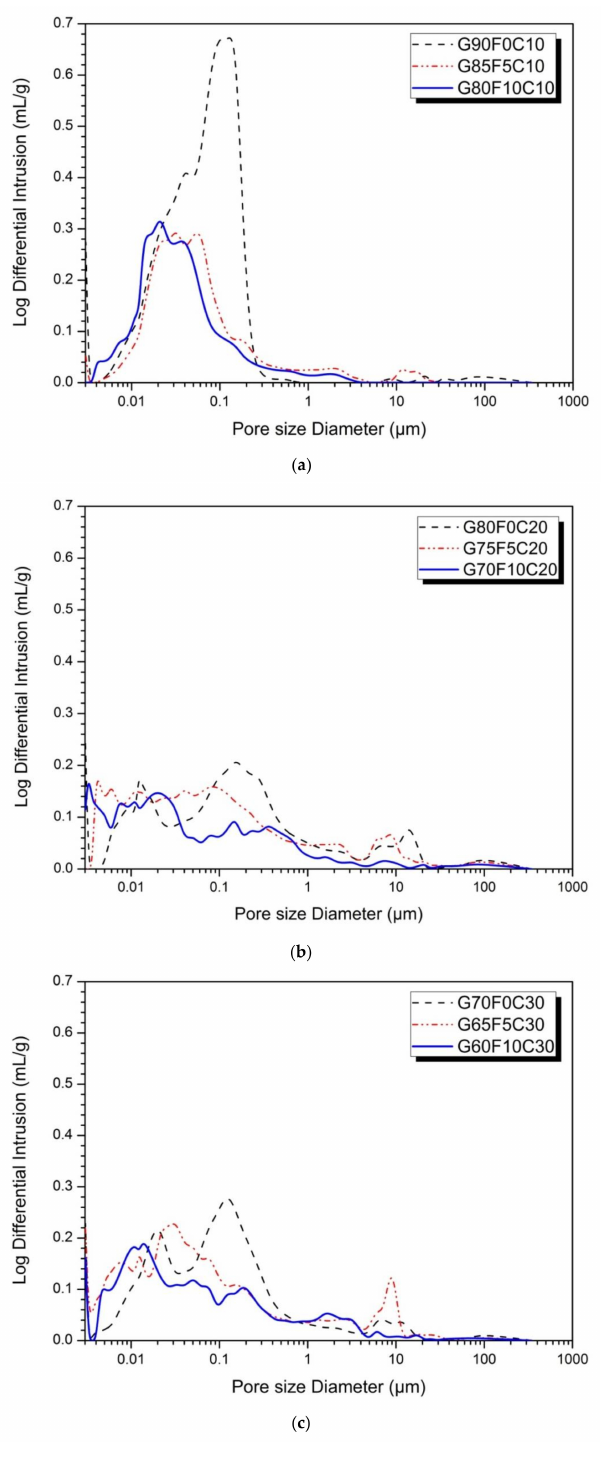
Figure 4. MIP results at 28 d, ( a ) 10% CSAe, ( b ) 20% CSAe, and ( c ) 30% CSAe.